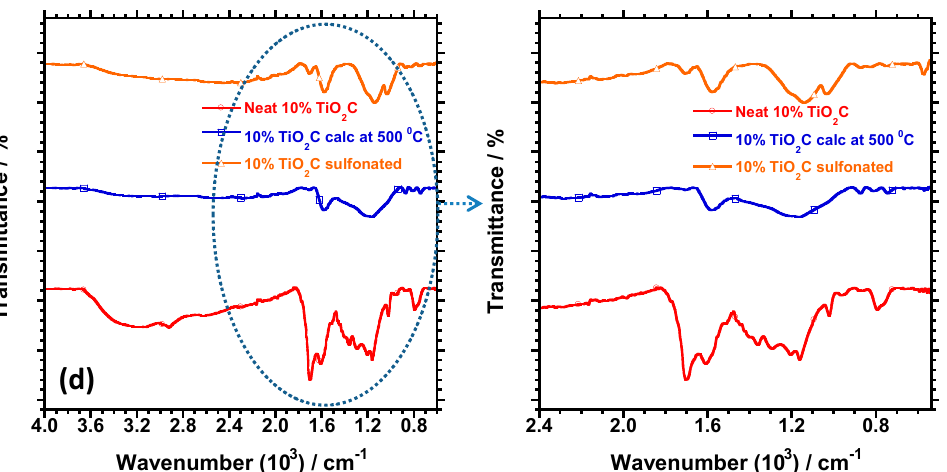
Figure 4. FTIR spectra of neat, calcined and sulfonated ( a ) carbon, ( b ) 1%TiO 2 C, ( c ) 5%TiO 2 C, and ( d ) 10%TiO 2 C.